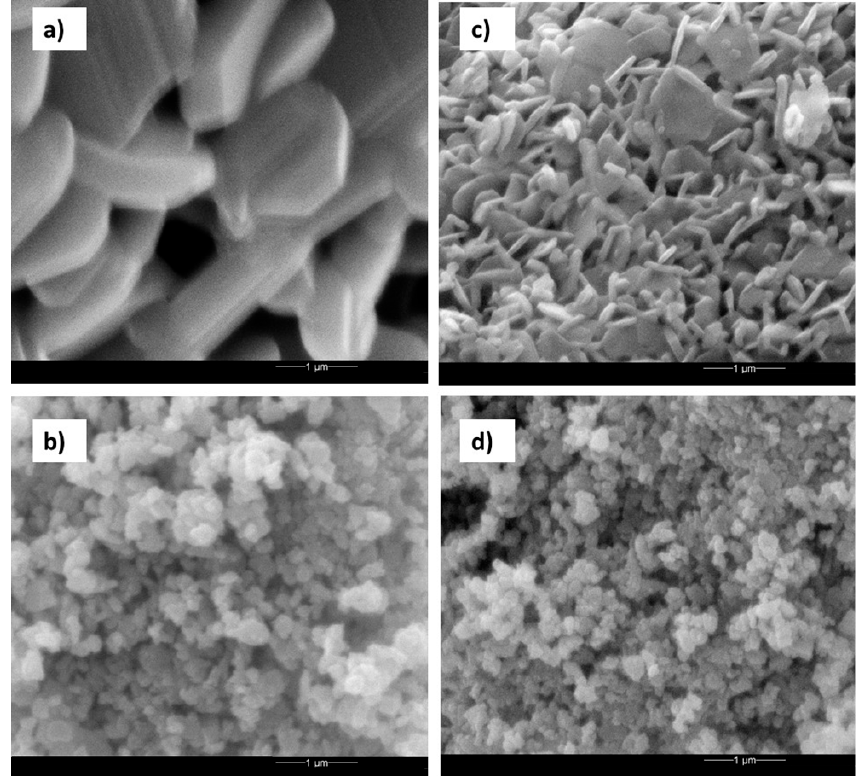
Figure 3. SEM micrographs of BaFeHF and BaFeHAl before ( a , c ) and after HEM treatment ( b , d ),